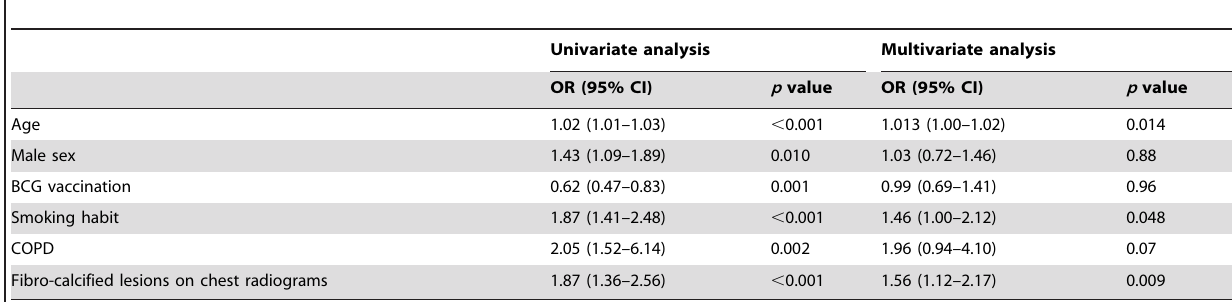
Table 2. Univariate and multivariate analysis of clinical factors associated with latent TB infection in high-risk individuals a .